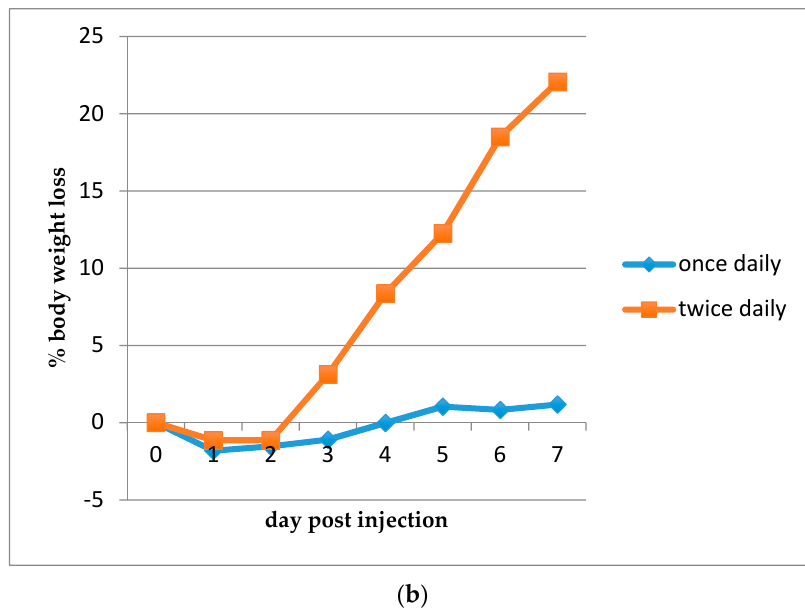
Figure 5. Effect of 20 mg/kg Compound 6 on body weight using two dosing regimens. ( a ) Body weight loss in grams following dosing once or twice, 6 h apart, for four consecutive days. ( b ) Percent body weight loss following dosing once or twice, 6 h apart, for four consecutive days. Two groups of 8-week old Female Swiss CD.1 mice were injected SC with 20 mg/kg of Compound 6 ( n = 8). Mice were weighed daily for 7 days. Each point indicates mean ± SEM.